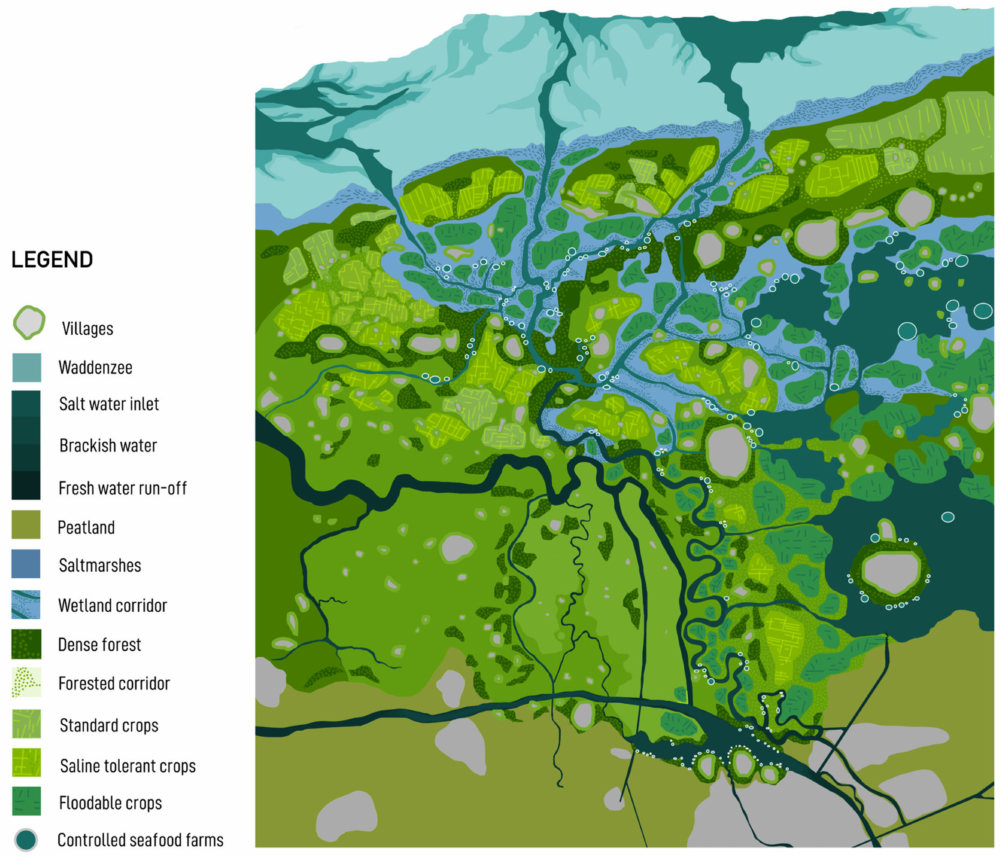
Figure 11. Landscape